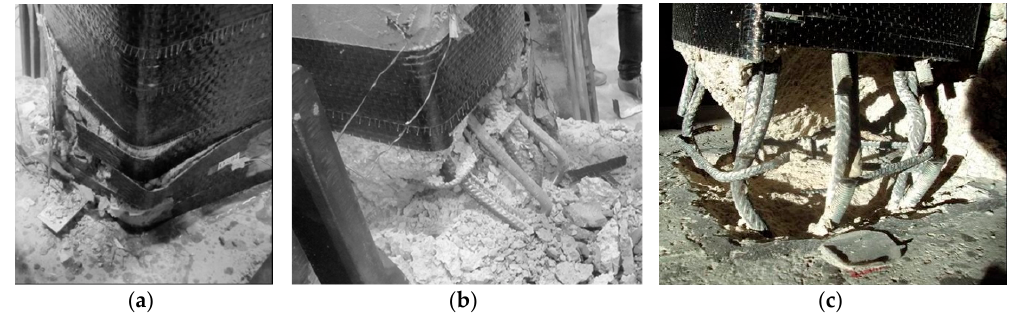
Figure 15. Damage of specimens strengthened with the system “type A”.